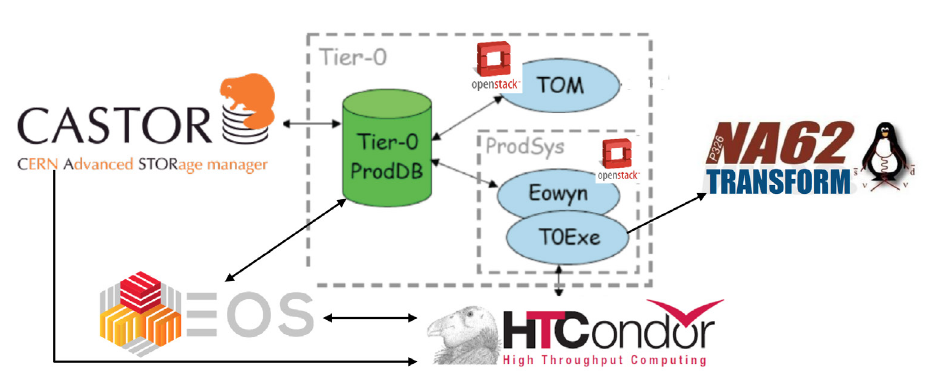
Figure 4. The NA62 Tier-0 production system, together with the CERN CPU and storage components with which it interacts. The Tier-0 comprises an Oracle database backend (ProdDB), the Tier-0 Manager (TOM) which creates new jobs in ProdDB based on the data preparation workflow configuration, and the ProdSys subsystem. The ProdSys subsystem looks for jobs in ProdDB, submits executables (T0Exe) to a batch system (in this case HTCondor) and monitors the status of the batch system. Finally, job management on the HTCondor worker nodes is performed by T0Exe which performs file input and output management, runs the NA62 reconstruction or analysis code, captures errors and produces job reports. For more details see